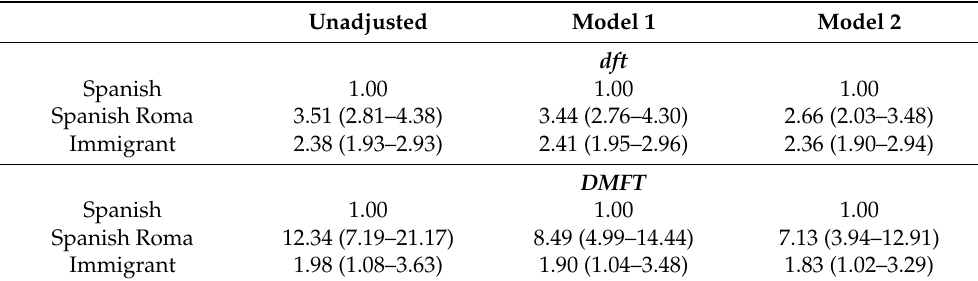
Table A1. Rate Ratios and their 95% Confidence Intervals of dental caries outcomes for parental migratory status/ethnicity: Children’s Oral Health Survey, Municipality of Bilbao,